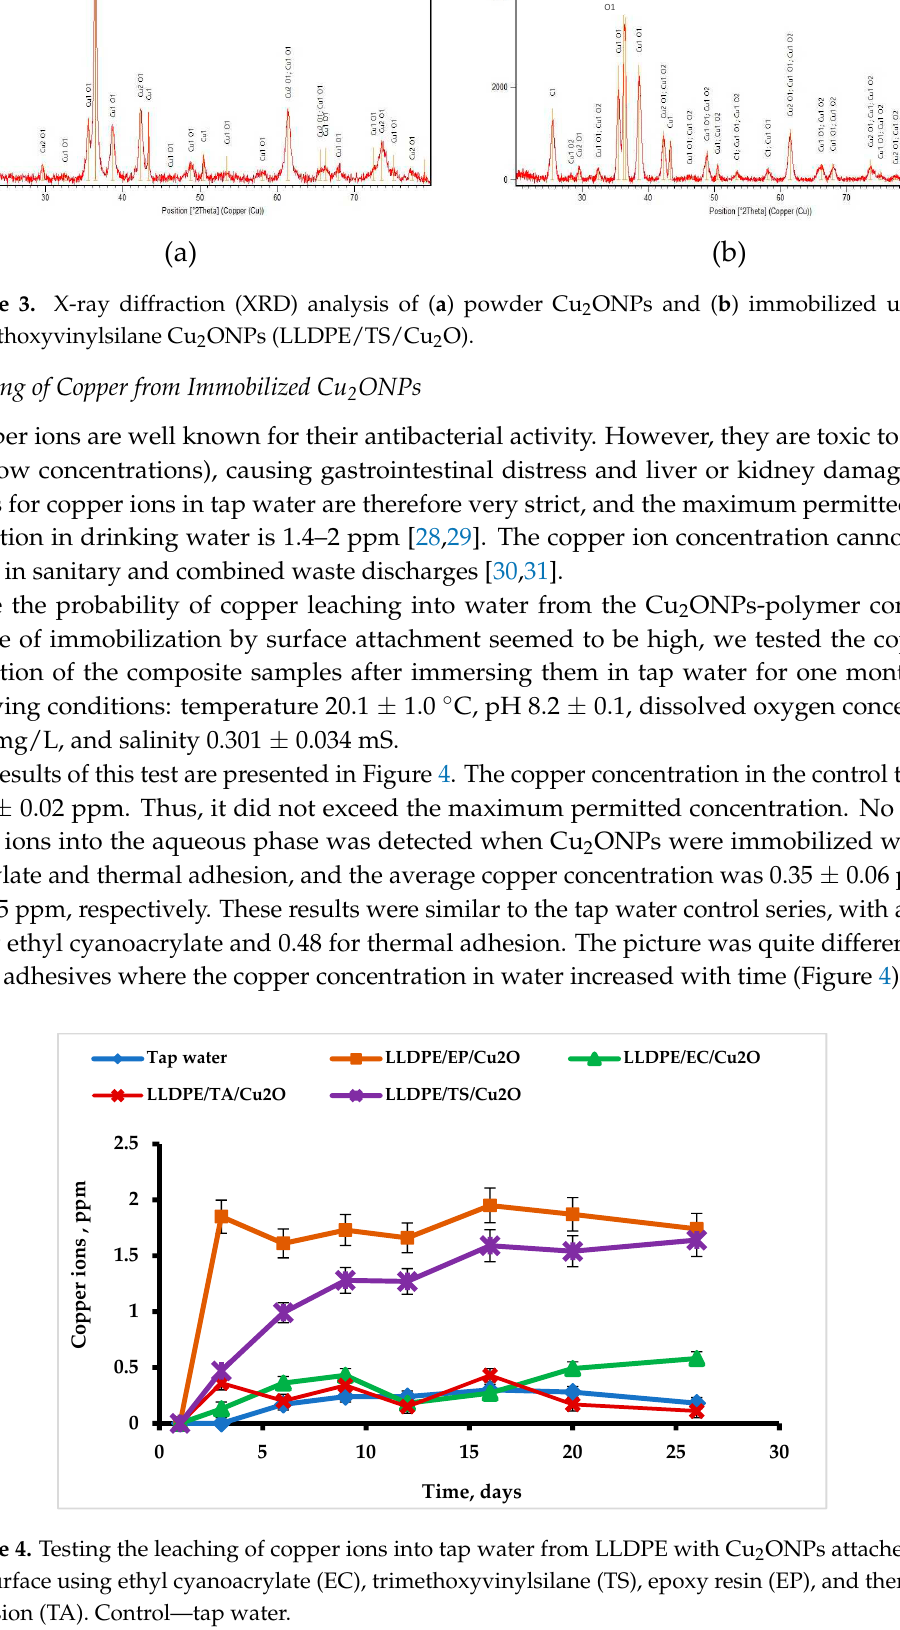
7 Figure 2. Surface elemental mapping of gold-coated ( a ) powder Cu 2 ONPs; ( b ) Cu 2 ONPs immobilized onto LLDPE by extrusion; ( c ) Cu 2 ONPs immobilized onto LLDPE using ethyl cyanoacrylate; ( d )